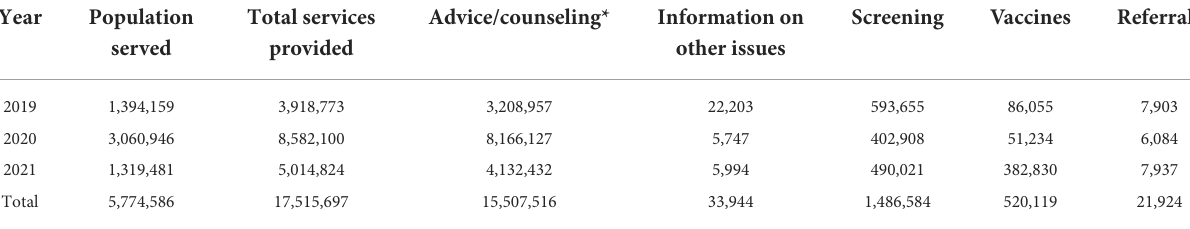
TABLE 1 Population served and services provided at VDS, January 2019—December